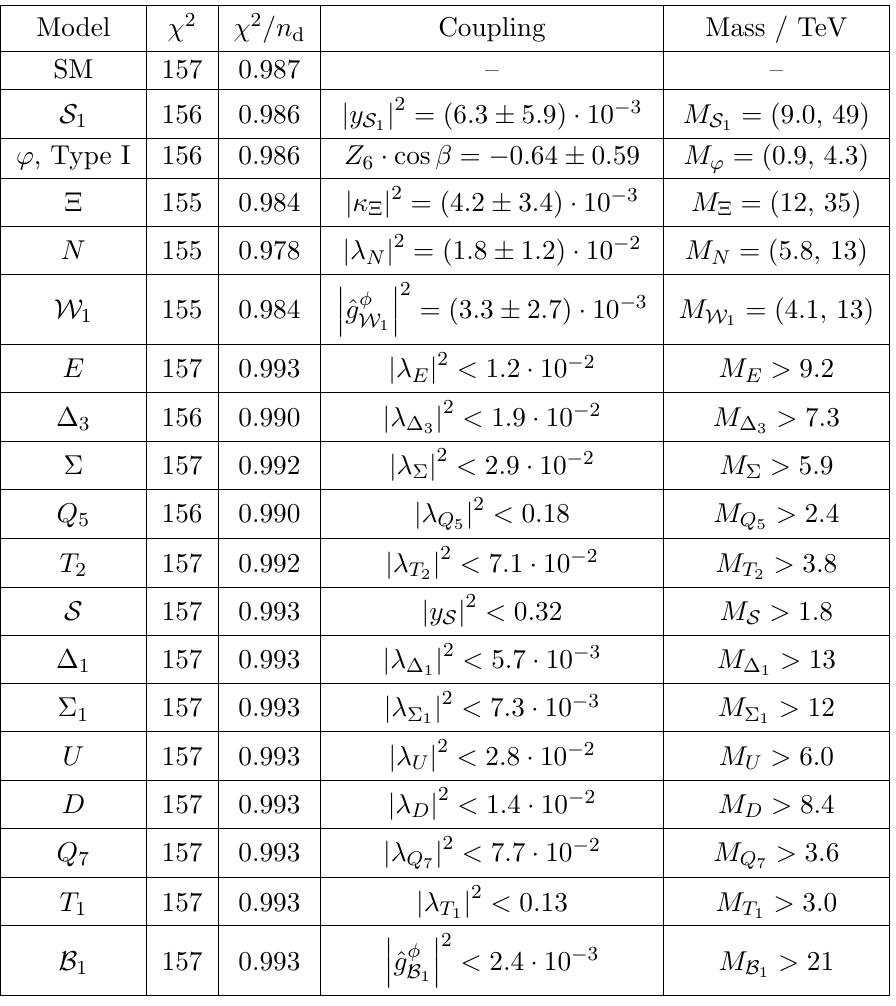
Table 7. Single-parameter renormalizable extensions of the SM, which is included for the sake of comparison. The coupling bound assumes a mass of 1 TeV, and the mass range assumes a coupling of one. All bounds are at the 1 (cid:0) (cid:27) level. The (cid:12)rst set of models below the SM improve both the (cid:31) 2 and the (cid:31) 2 =n d , whereas the middle set of models only improve the (cid:31) 2 (numeric values have been rounded). The bottom set of models improve neither the (cid:31) 2 nor the (cid:31) 2 =n d . Model ’ is the 2HDM; see the text for more discussion of this